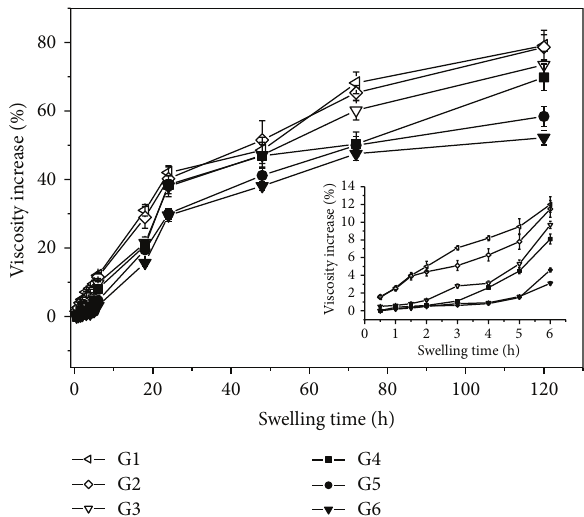
Figure1:Swellingcourseofthehydrogels.Theinsertedfigureshows the initial part of the swelling process.